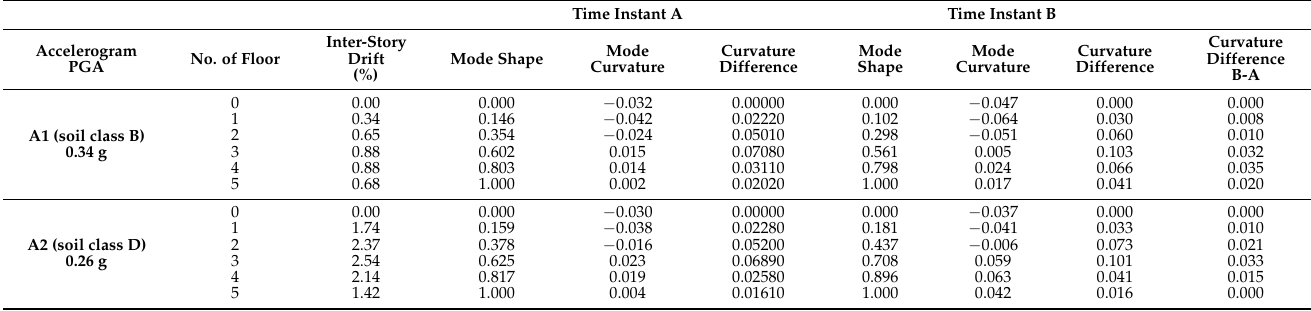
Table A5. Values of the main parameters evaluated for the 5-story numerical model with irregular plan in correspondence to the fundamental mode of